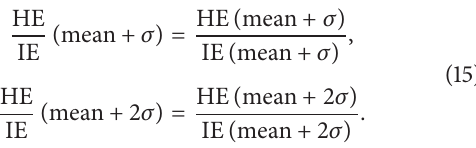
mean + 𝜎 and mean + 2𝜎 of input energy spectral values are